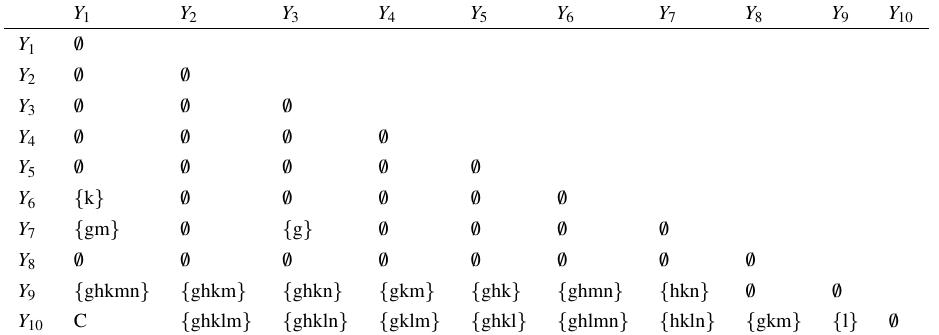
Table 3: Discernibility matrix of decision